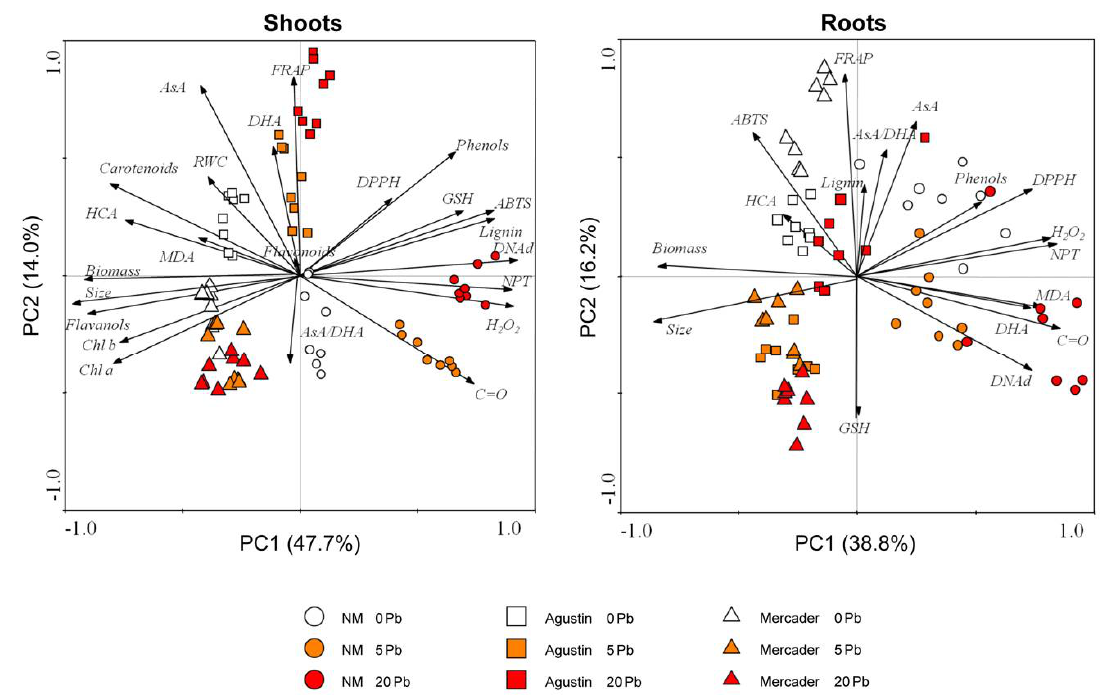
Figure 7. PCA analyses of functional responses of seedlings from non-mining (NM) and mining (Agustin and Mercader) Z. fabago populations exposed to 0, 5 and 20 µM Pb(NO 3 ) 2 for 4 weeks. For shoots, variance explained by the two first components was: X—axes 47.7% (PC1); Y—axes 14.0% (PC2). For roots, variance explained by the two first components was: X—axes 38.8% (PC1); Y—axes 16.2% (PC2).